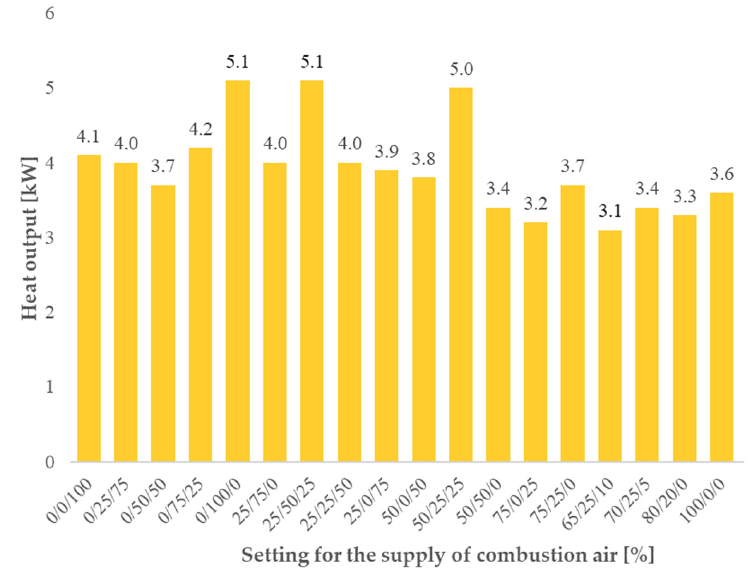
Figure 4. The heat output comparison during different settings for air supply.